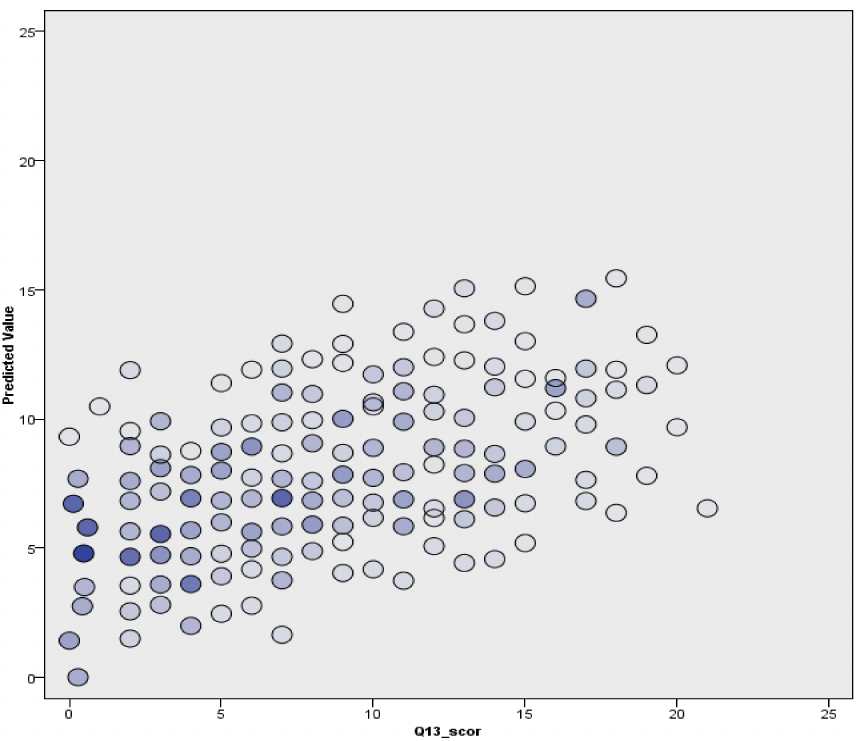
Figure 5. Multiple linear regression